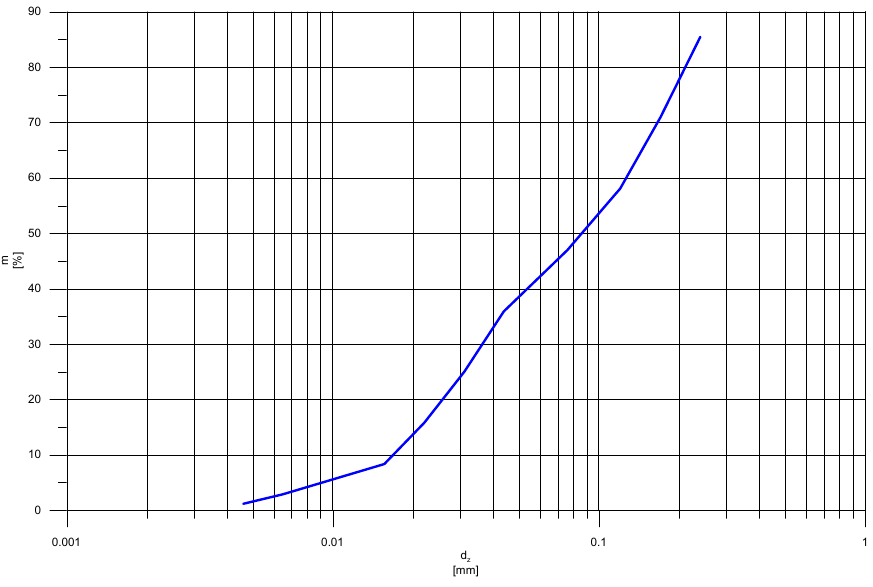
Figure 2. Grade curve of used solid phase.